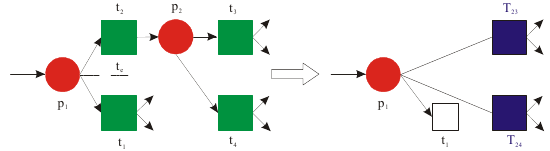
Fig 15. “OR” branch transition reduction rule The “OR” branch transitions reduction process in Fig.15